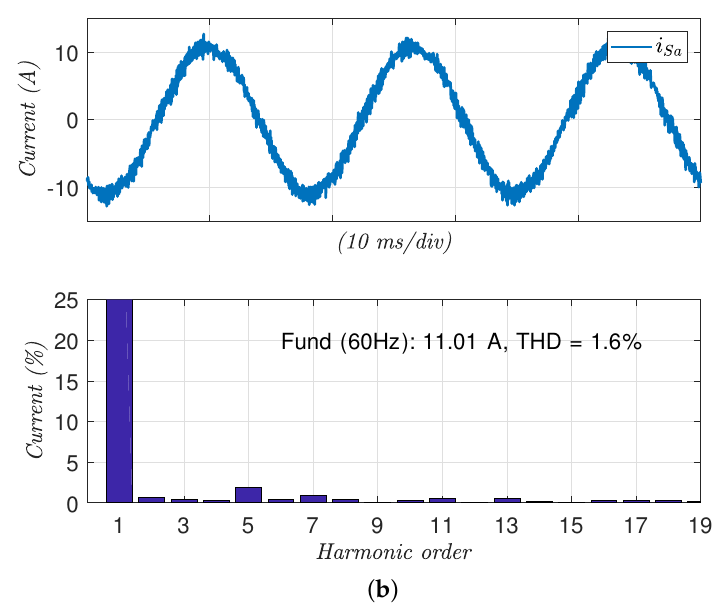
Figure 7. Grid current harmonics for phase-leg a : ( a ) Before compensation, ( b ) after compensation.